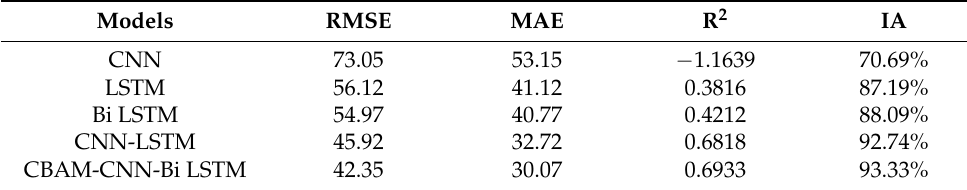
Table 9. Performance evaluation indicators for model prediction of PM 10 (h13–h48). Models